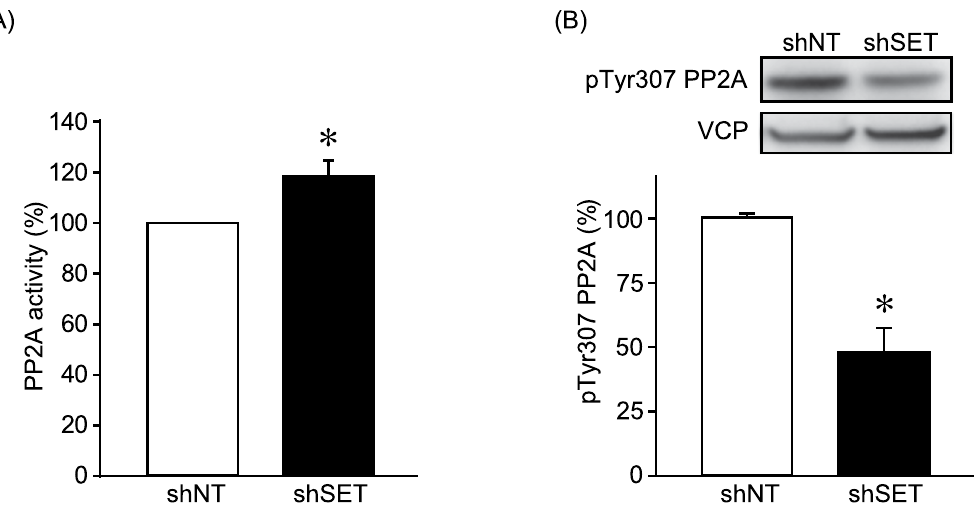
Figure 5. SET knockdown enhanced PP2A activity. ( A ) PP2A phosphatase activity of CIP-m cells was analyzed as indicated in material and methods. Quantitative data from 3 independent experiments performed duplicate are shown. * P < 0.05 vs. shNT. ( B ) PP2A Tyr307 phosphorylation levels of CIP-m cells were determined by immunoblotting. Band density of phospho-Try307 was normalized with the band density of shNT expressing CIP-m cells as 100%. VCP was used as a loading control. Quantitative data from 4 independent experiments are shown. * P < 0.05.